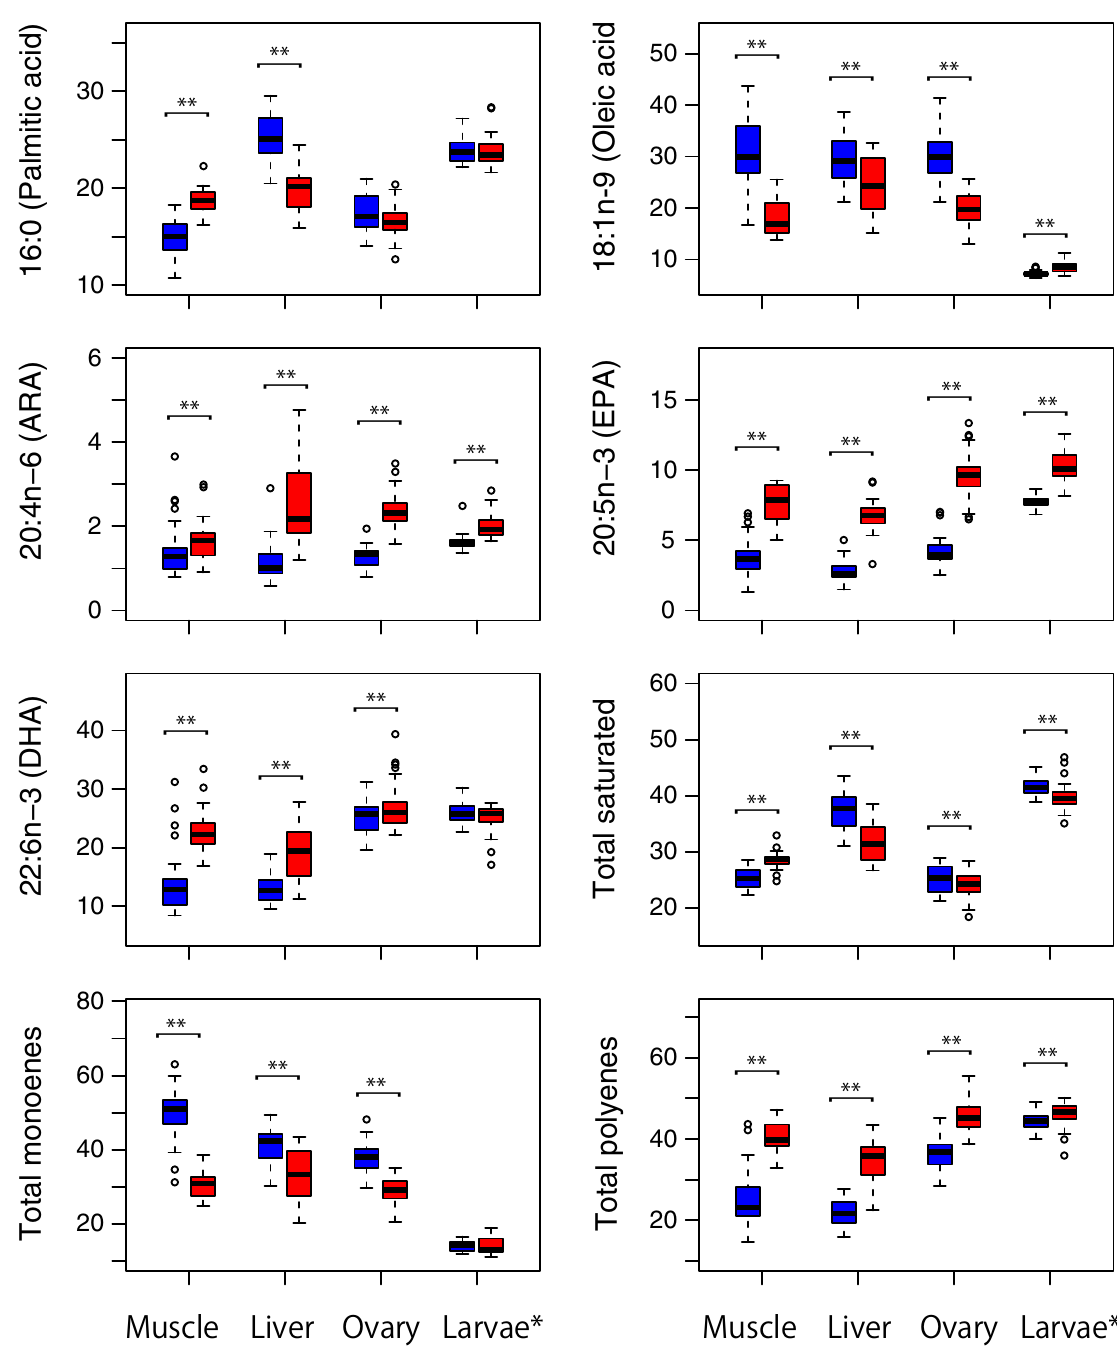
Fig 6. Proportional contribution of individual fatty acids in muscle, liver, ovary tissues, and larvae of Pacific bluefin tuna caught around the Nansei Islands (blue) and in the Sea of Japan (red). Boxes depict the first, median and third quartiles, the lowest and highest datum within 1.5 interquartile range of the first and third quartiles, and outliers (plotted individually). � after Matsumoto et al. [30]. �� statistically significant difference ( P < 0.01, Wilcoxon-Mann Whitney